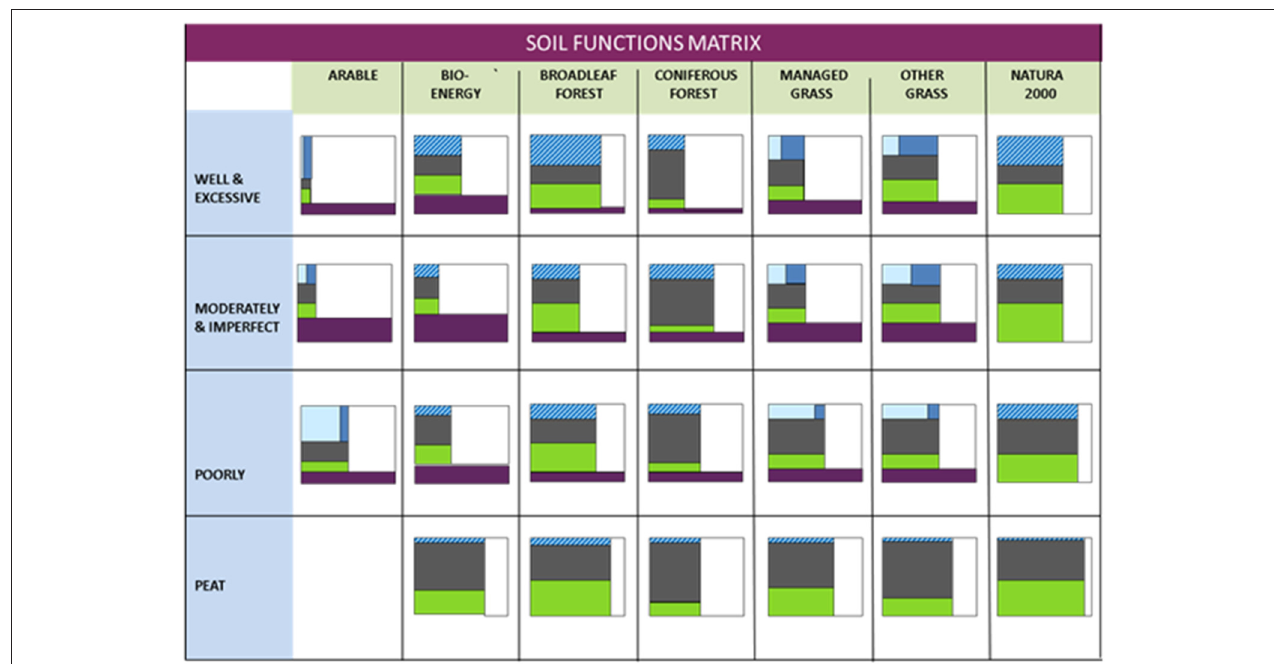
FIGURE 2 | Soil Functions Matrix (adapted from Coyle et al., 2015) illustrating the supply of the five soil functions (the size of the five boxes) in relation to land use (horizontal axis) and soil drainage (vertical axis). White boxes indicate primary production; blue, water purification and regulation; black, carbon storage and regulation; green, provision of a habitat for biodiversity; purple, cycling of